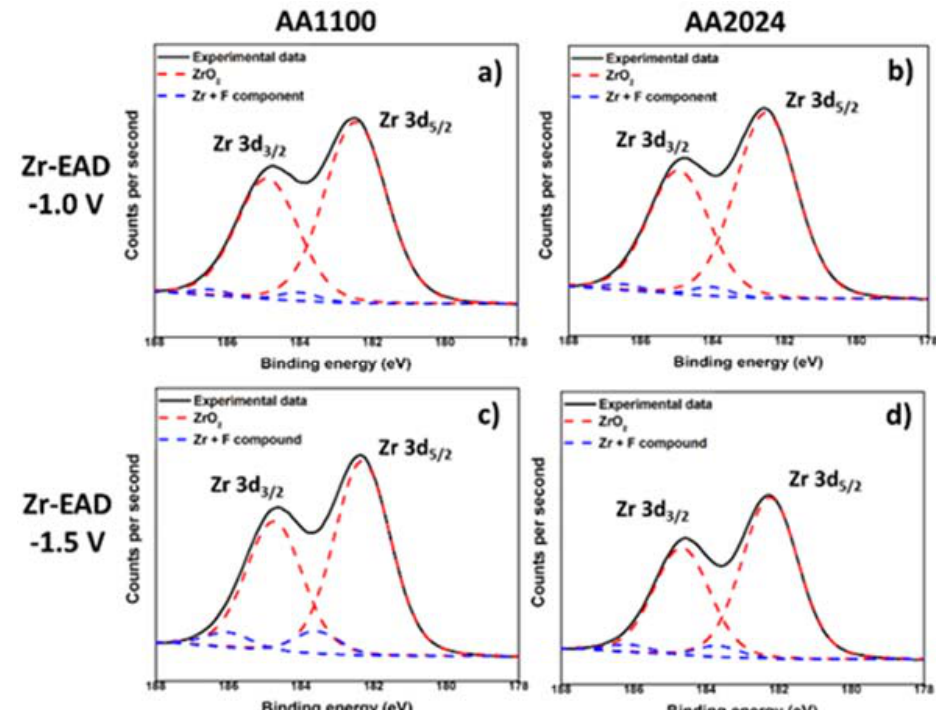
Figure 3. XPS high-resolution spectra of Al 2p region, before (Raw, a , b ) and after alkaline etching process (Bare, c , d ), and after electro-assisted deposition of ZrO 2 , generated at − 1.0 V ( e , f ) and − 1.5 V ( g , h ). Left: AA1100 samples and right: AA2024 samples.